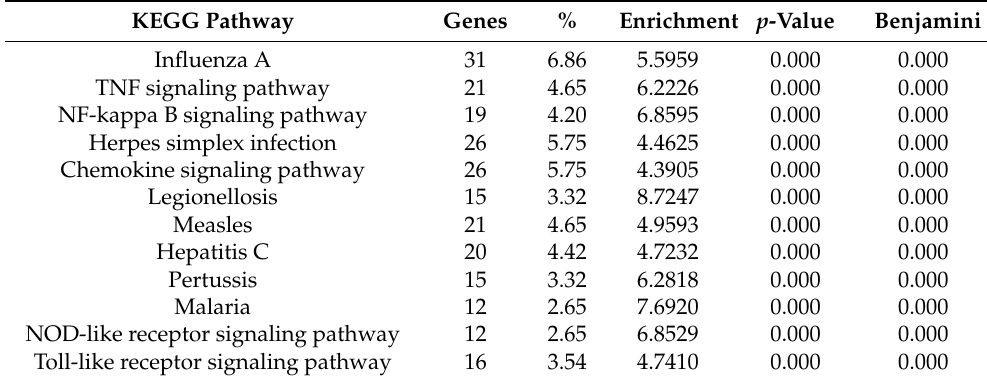
Table 4. Enriched gene ontology categories of the transcripts in P.BCG compared against the control. P.BCG: Mycobacterium bovis